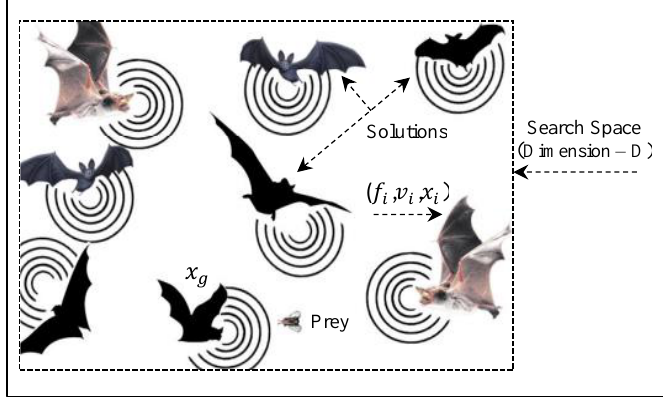
Figure 1: Flock of Bats in search of